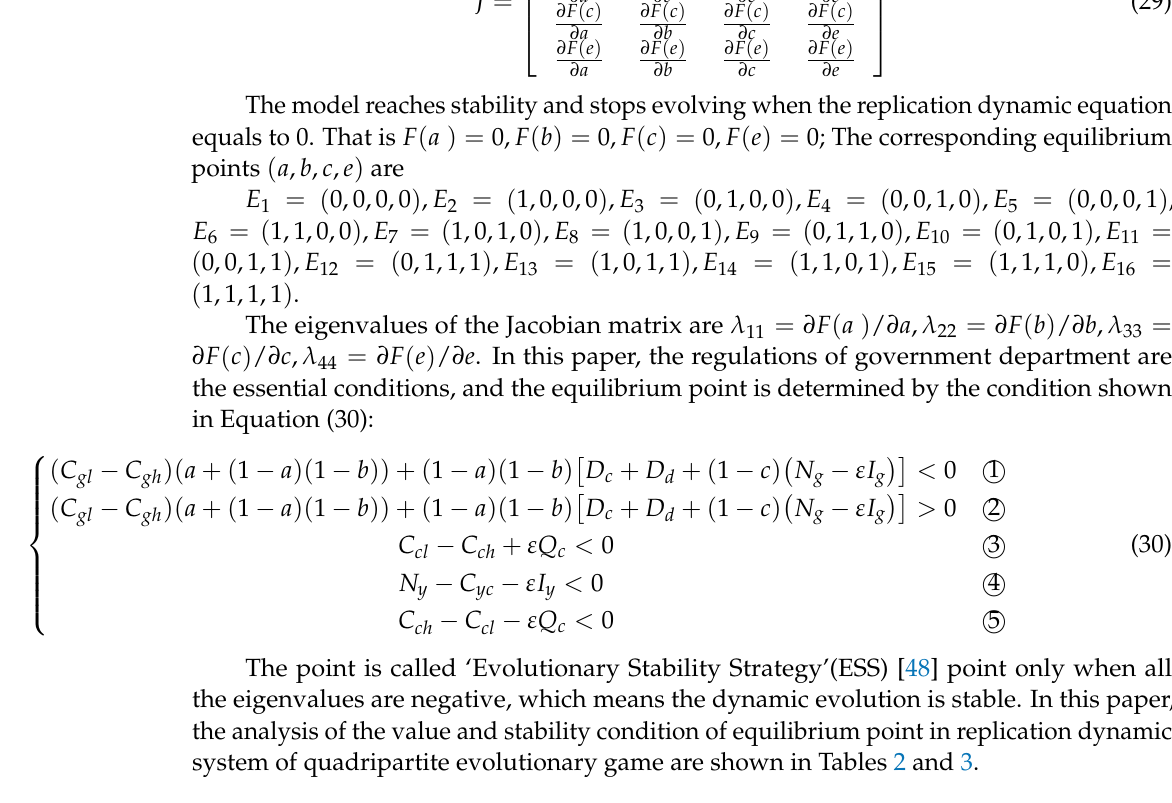
Table 2. ESS of quadripartite evolutionary game replicated dynamic